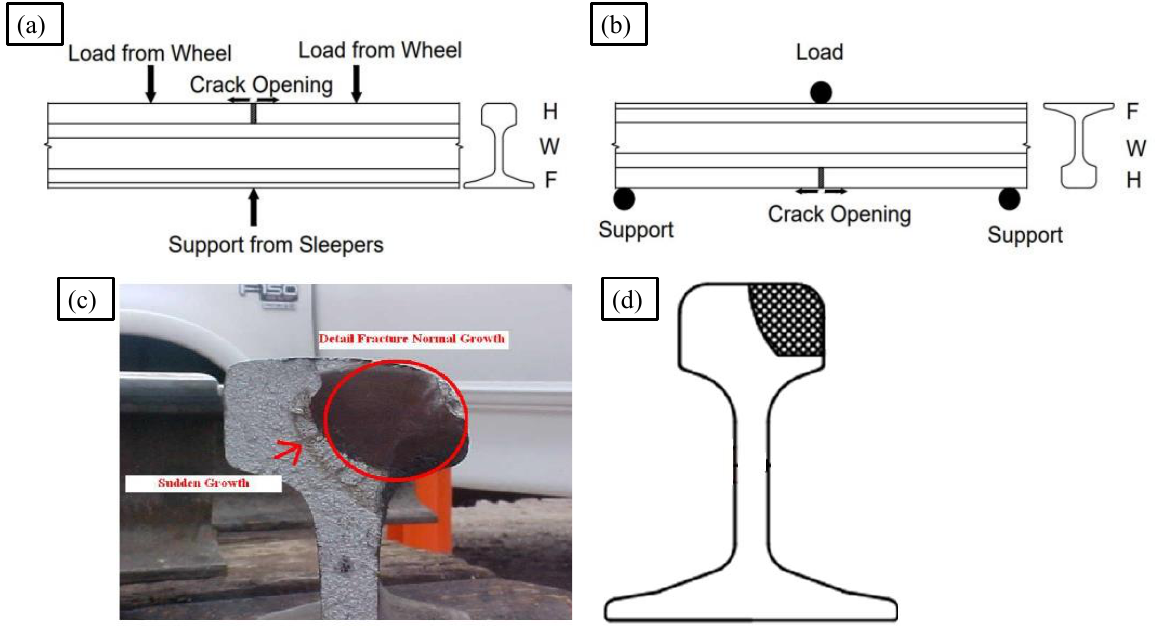
Figure 3. Concept behind three-point bending experiment of acoustic emission generated by crack opening in rail section ( a ) Crack under train load ( b ) Load on inverted rail ( c ) Actual damage in rail ( d ) Simulated damage.